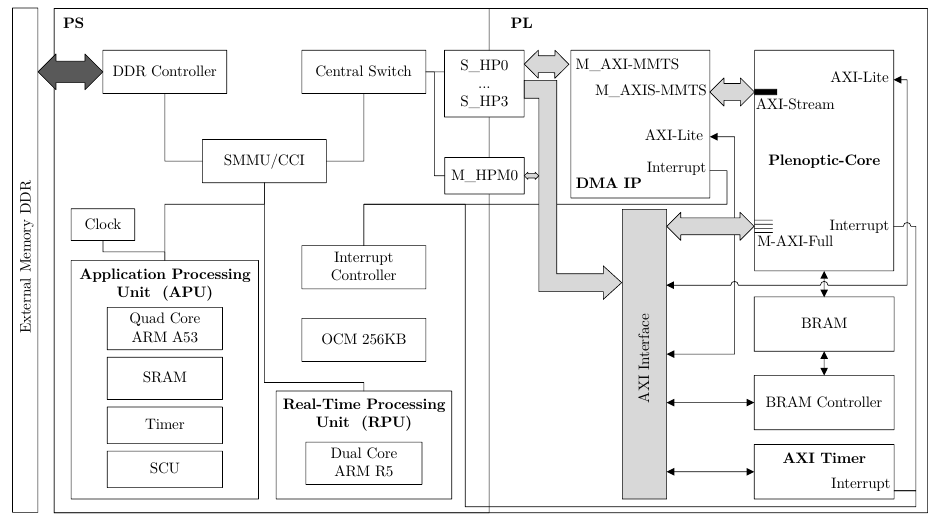
Figure 17. Xilinx Zynq UltraScale+ based hardware design for the plenoptic camera